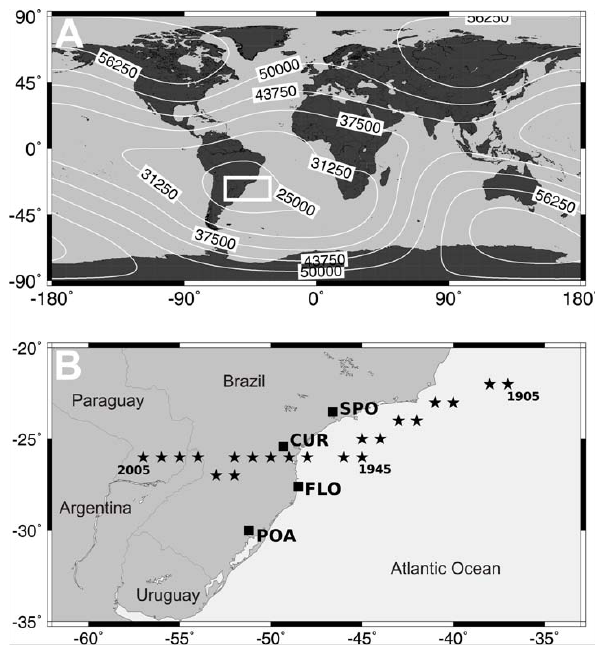
Fig. 1. (A) Global geomagnetic field intensity map computed from IGRF data for 2005. The study area is bounded by the white rectan- gle. (B) Enlarged map of the study area showing the locations of the weather stations (SPO, CUR, FLO and POA) and the SAMA center drift from 1905 to 2005 (black stars), computed every 5yr.